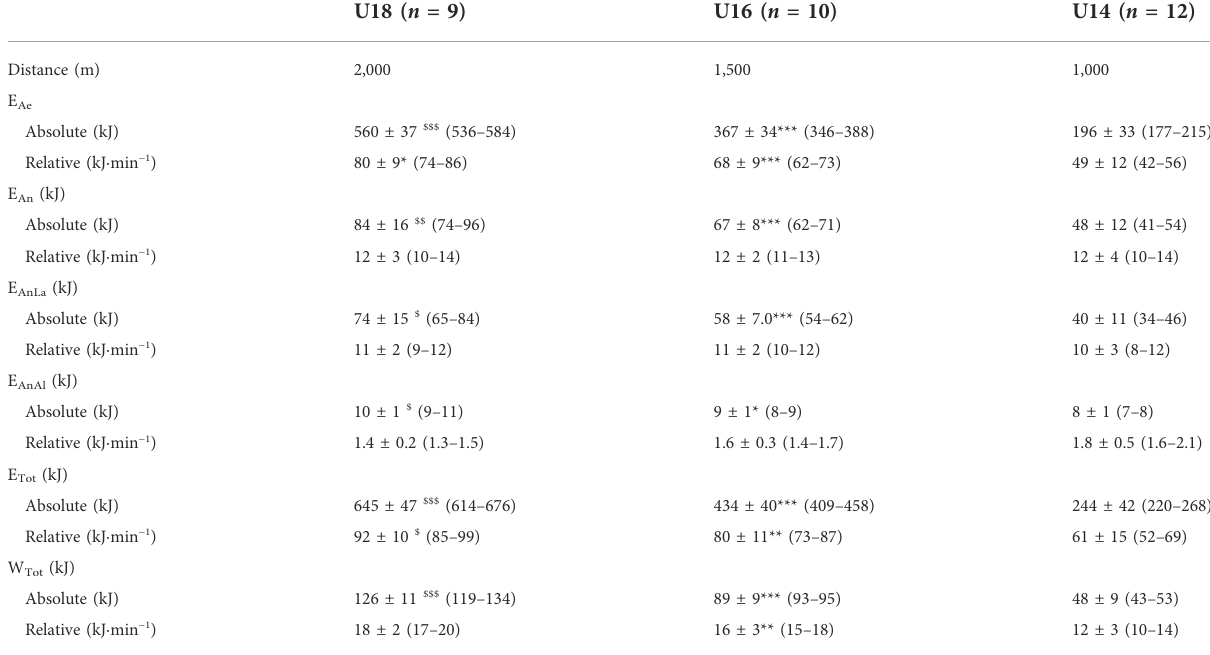
TABLE 3 Amount of energy released from metabolic pathways and mechanical work produced during the rowing ergometer test over 2,000 m for rowers under 18 years (U18), 1,500 m for rowers under 16 years (U16) and 1,000 m for rowers under 14 years